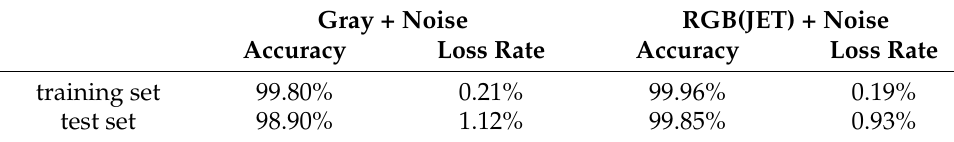
Figure 19. ( a , c ) The original image, ( b , d ) the image with Gaussian noise. Table 5. The classification results of the CNN model after adding Gaussian